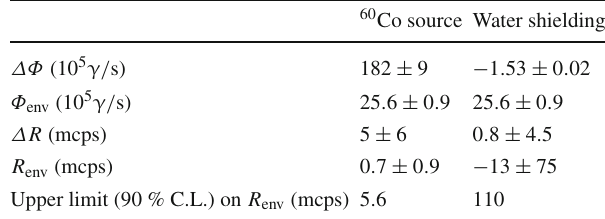
Table 8 Background rate R env induced by environmental gamma radi- ation under standard conditions (symmetric magnetic field and Δ U IE = − 100 V). The relevant values used to calculate this rate are also listed; the values of ΔΦ and Φ env come from Table 5. A corrective factor of 2.6 was applied to the upper limit on R env for the 60 Co